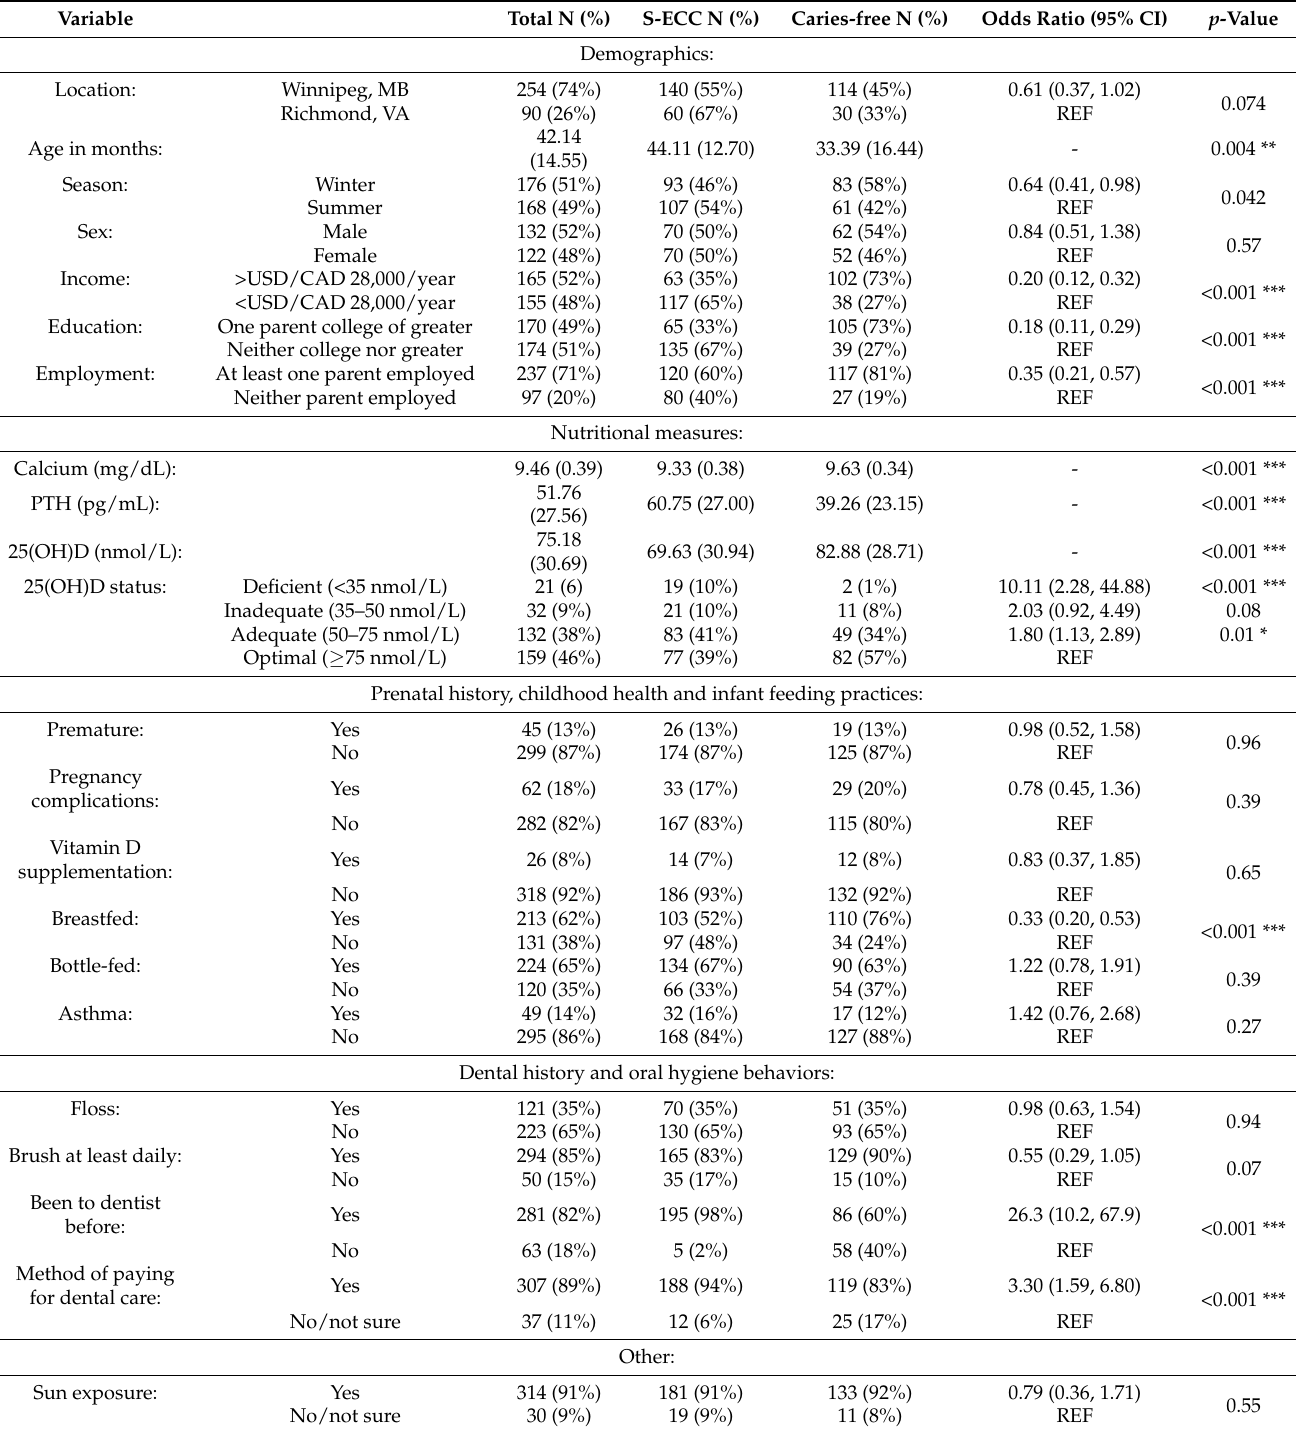
Table 1. Association between caries status and child and caregiver characteristics and nutritional